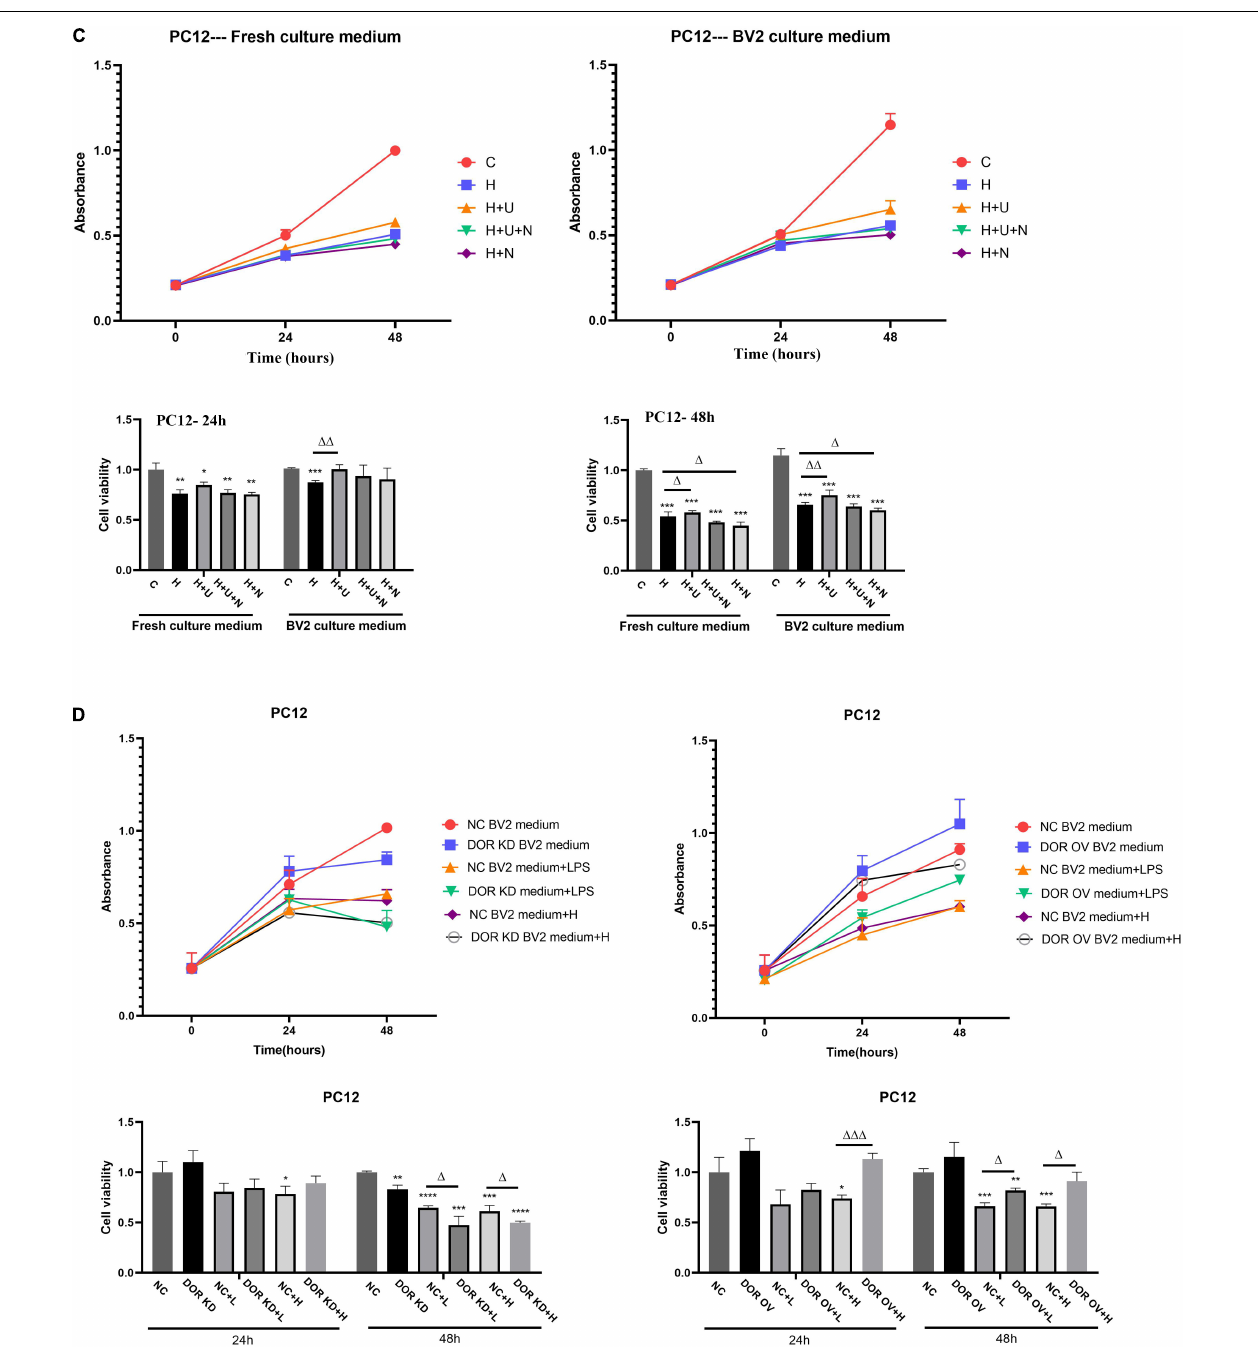
FIGURE 6 | Effects of conditioned medium from BV2 cells with δ -opioid receptor (DOR) activation/inhibition on PC12 cell viability in LPS or hypoxic stress. C: the control. L: LPS. L + U: direct UFP-512 treatment or medium from UFP-512 treated BV2 cells under LPS insult. L + U + N: direct treatment of UFP-512 plus naltrindole or medium from UFP-512 plus naltrindole-treated BV2 cells under LPS insult. L + N: PC12 cells were directly treated with naltrindole or cultured with the conditioned medium from naltrindole-treated BV2 cells in LPS insult. H: hypoxia. H + U: UFP-512 plus hypoxia. H + U + N: UFP-512 plus naltrindole under hypoxia. H + N: hypoxia plus naltrindole. NC: negative control. DOR KD: PC12 cells were cultured in the medium from BV2 cells with DOR knockdown. OV: PC12 cells were cultured in the medium from BV2 cells with DOR overexpression. + L: PC12 was cultured in BV2 medium and then exposed to LPS insult. +H: PC12 was cultured in BV2 medium and then exposed to hypoxic insults. (A) Schematic diagram showing CCK8 measurements of highly differentiated PC12 cells after being treated with conditioned medium from BV2 culture. (B) Cell viability and DOR-mediated alterations in cell proliferation under LPS insult. * p < 0.05, ** p < 0.01, *** p < 0.001 vs. C; (cid:49) p < 0.05, (cid:49) (cid:49) p < 0.01 vs. L. Note that LPS caused a significant decrease in cell viability, applications of the conditioned medium from UFP-512 treated BV2 cells largely increased the cell viability at both 24-h timepoint and 48-h timepoint. Using the conditioned medium from naltrindole-treated BV2 cells also